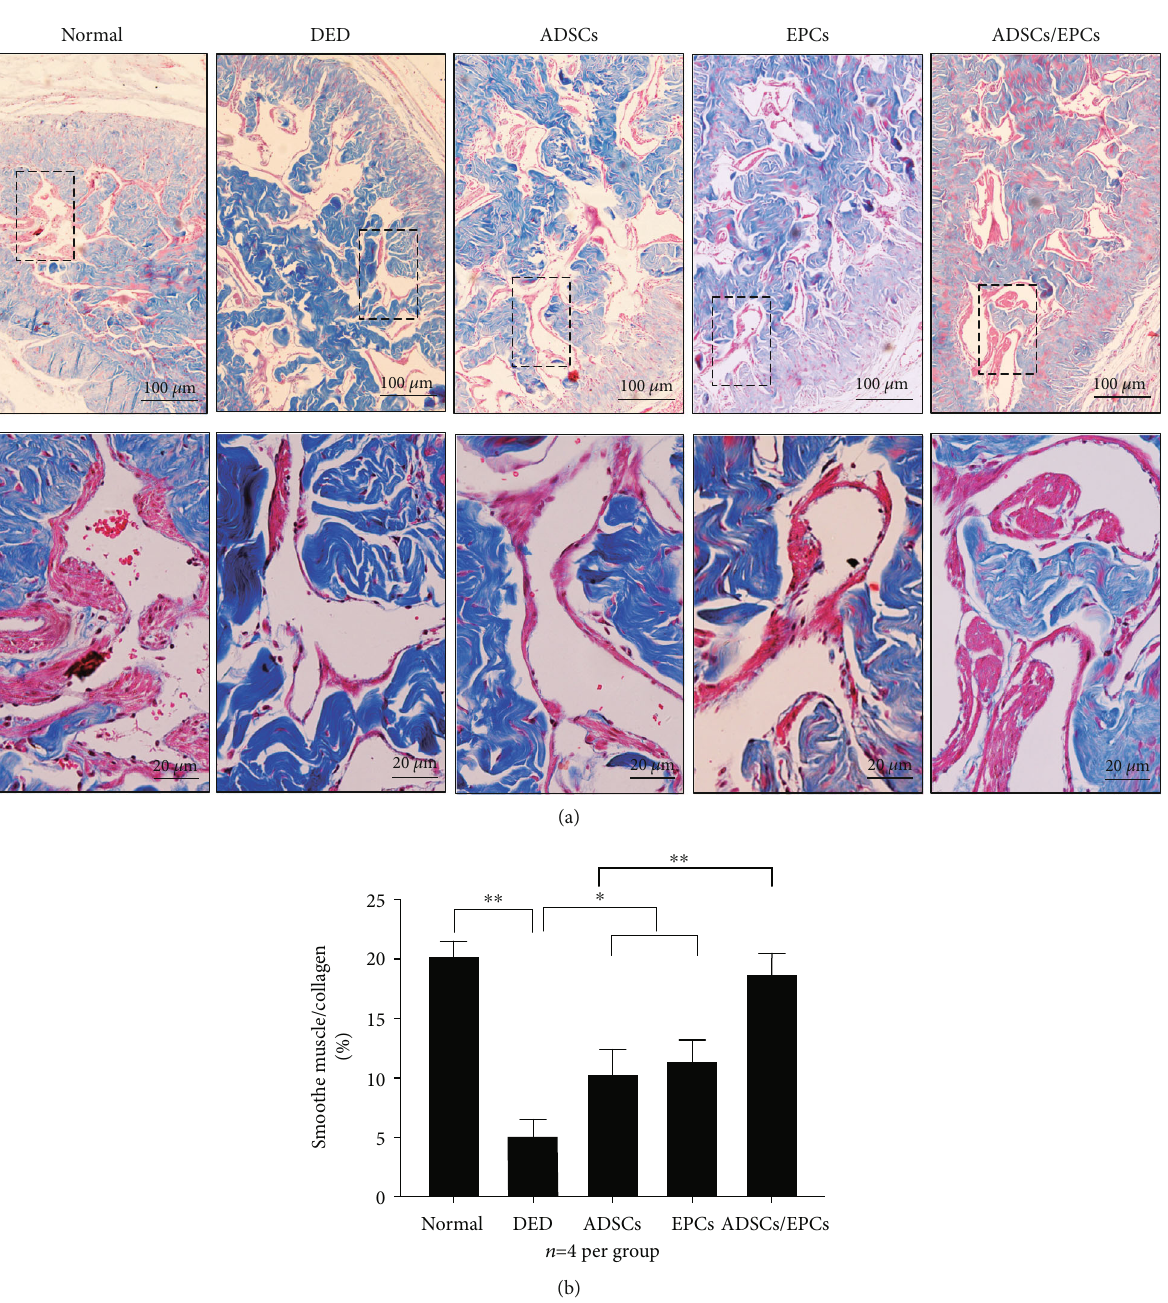
Figure 7: Combined transplantation of ADSCs and EPCs better increased smooth muscle content in the cavernosa in DED rats. (a) The representative images of Masson ’ s trichrome staining of the cavernous tissue. Scale bar: 100 μ m and 20 μ m. (b) The smooth muscle-to- collagen ratio in the cavernous tissue was calculated in each experimental group. n = 5 per group; ∗∗ p < 0 : 01 , ∗ p < 0 : 05